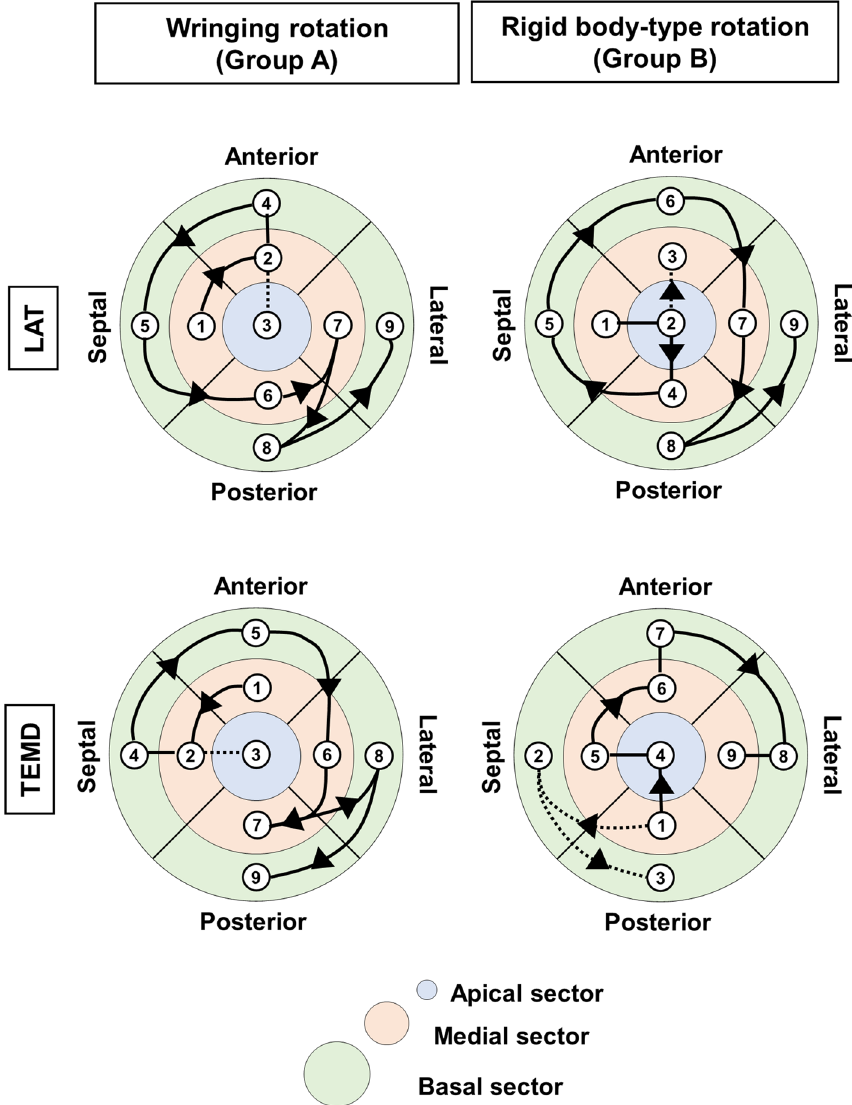
Figure 5. Segmental analysis of electro-mechanical activation fronts. Local activation time (LAT, top row), and total electro-mechanical delay (TEMD, bottom row) for the groups of left ventricle motion individuated. Numbers show the succession of segmental activation, connected by lines and arrows. Lines change dashing when a breakpoint on the electro-mechanical propagation front is